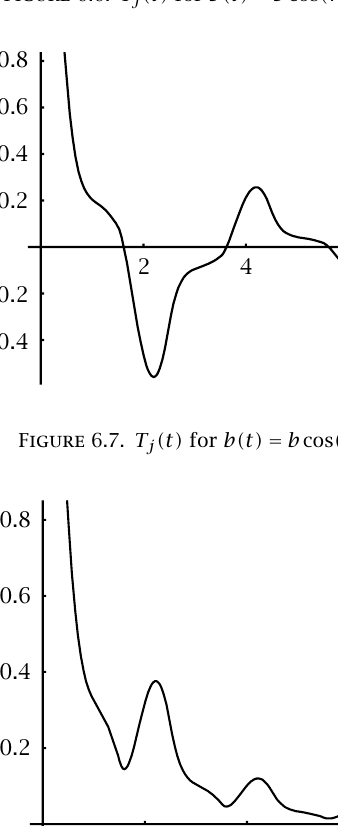
Figure 6.6 . T j (t) for b(t) = b cos (πt) , b = 3, d j = 3 . 85.